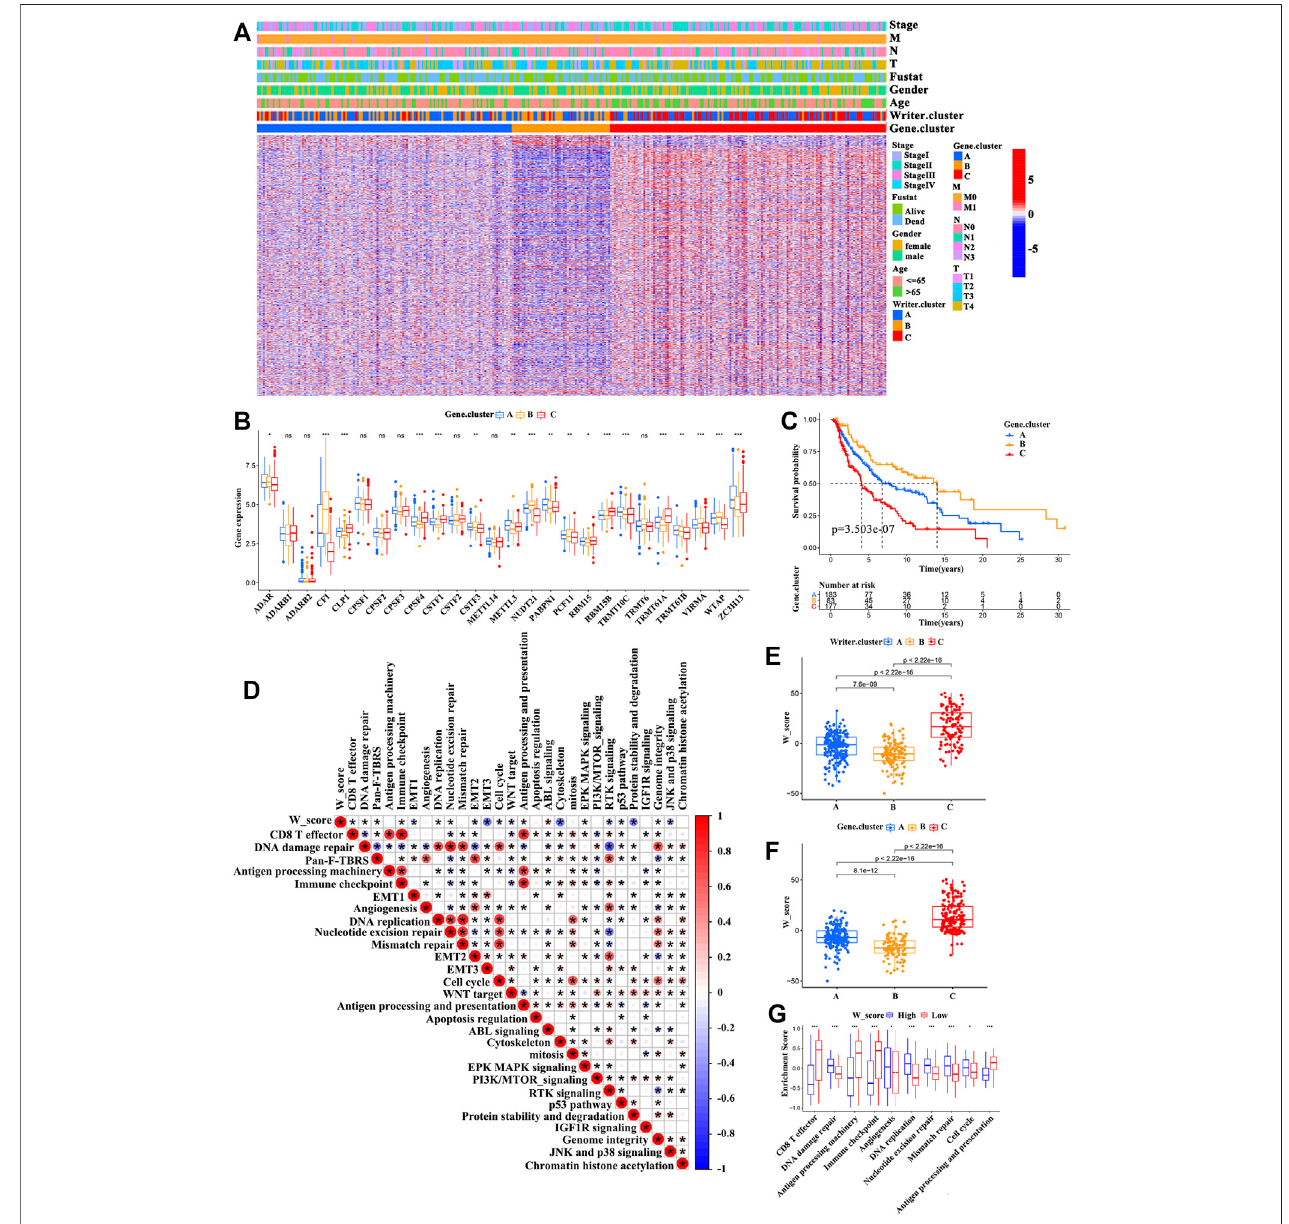
FIGURE 4 | Construction of the W_Score. (A) Unsupervised clustering of RNA modi fi cation phenotype-related differentially expressed genes (DEGs) in TCGA- SKCM cohort to classify patients into different genomic subtypes, de fi ned as gene cluster A, B, and C. The writer clusters, gene clusters, age, gender, clinical stage, T-stage, N-stage, M-stage and survival status were used as patient annotations. (B) The differences in expression of 26 A-related RNA modi fi cation “ writers ” in three gene clusters (TCGA-SKCM cohort). (ANOVA analysis; * p < 0.05; ** p < 0.01; *** p < 0.001). (C) The survival curves of three gene clusters based on 443 patients from TCGA-SKCM cohort (Log-rank test; p < 0.001). (D) The associations between W_Score and the known signaling pathways in TCGA-SKCM cohort. (E,F) Differences of the W_Score in writer clusters (E) and gene clusters (F) , respectively, in TCGA-SKCM cohort (K-W test; p < 0.001). (G) Differences in immune-related pathways between high- and low- W_Score groups. (* p < 0.05; ** p < 0.01; *** p < 0.001).